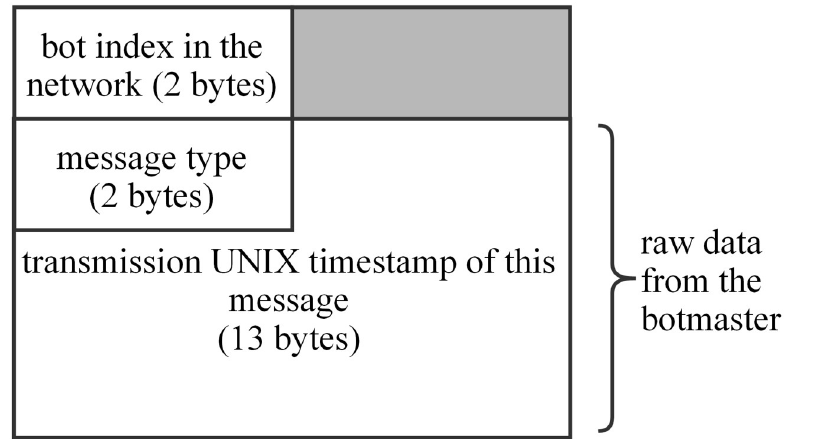
Fig 8. The data structure of the upstream